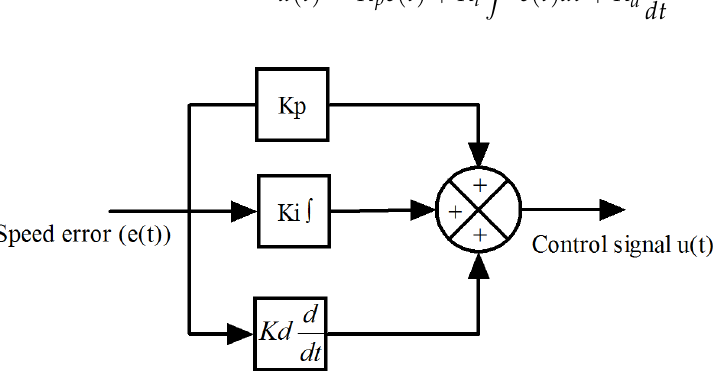
Figure 2. Formation of a conventional PID controller.